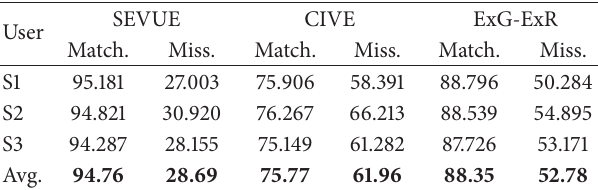
Table 2: Matching and missegmentation